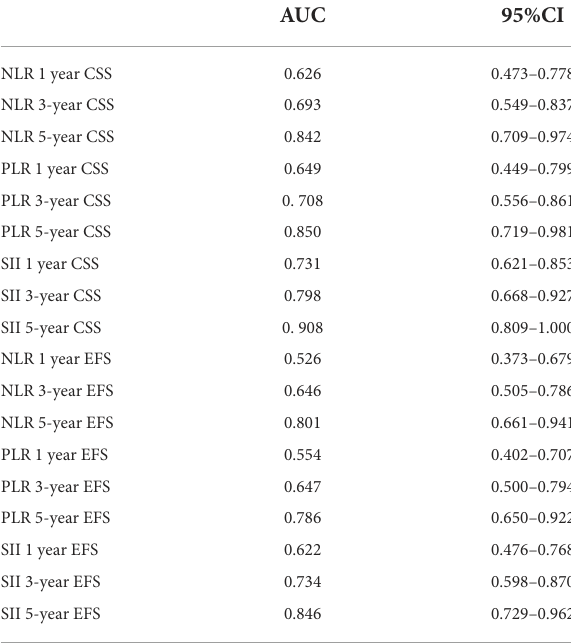
TABLE 2 AUC of the NLR, PLR, and SII for 1-, 3-, 5-year CSS and EFS of children with